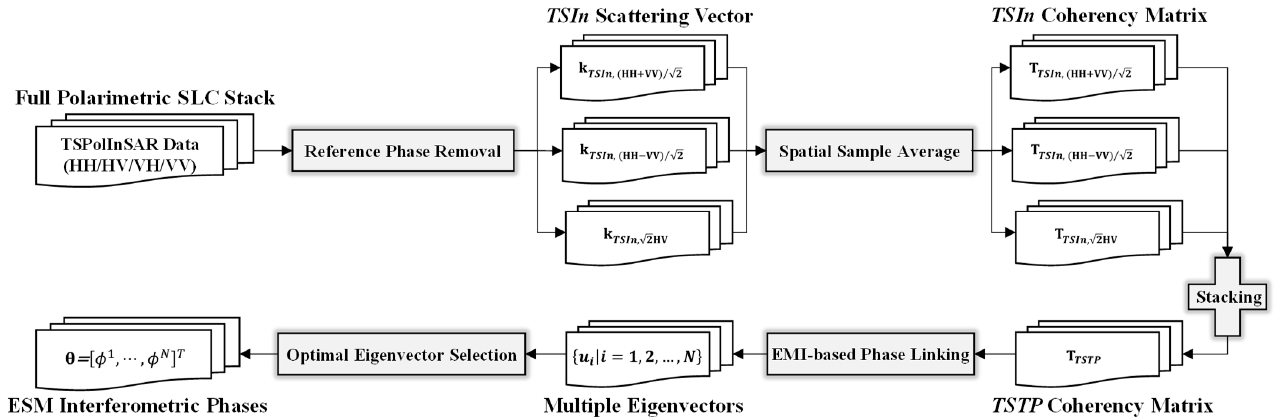
Figure 1. The flowchart of the proposed TSTP